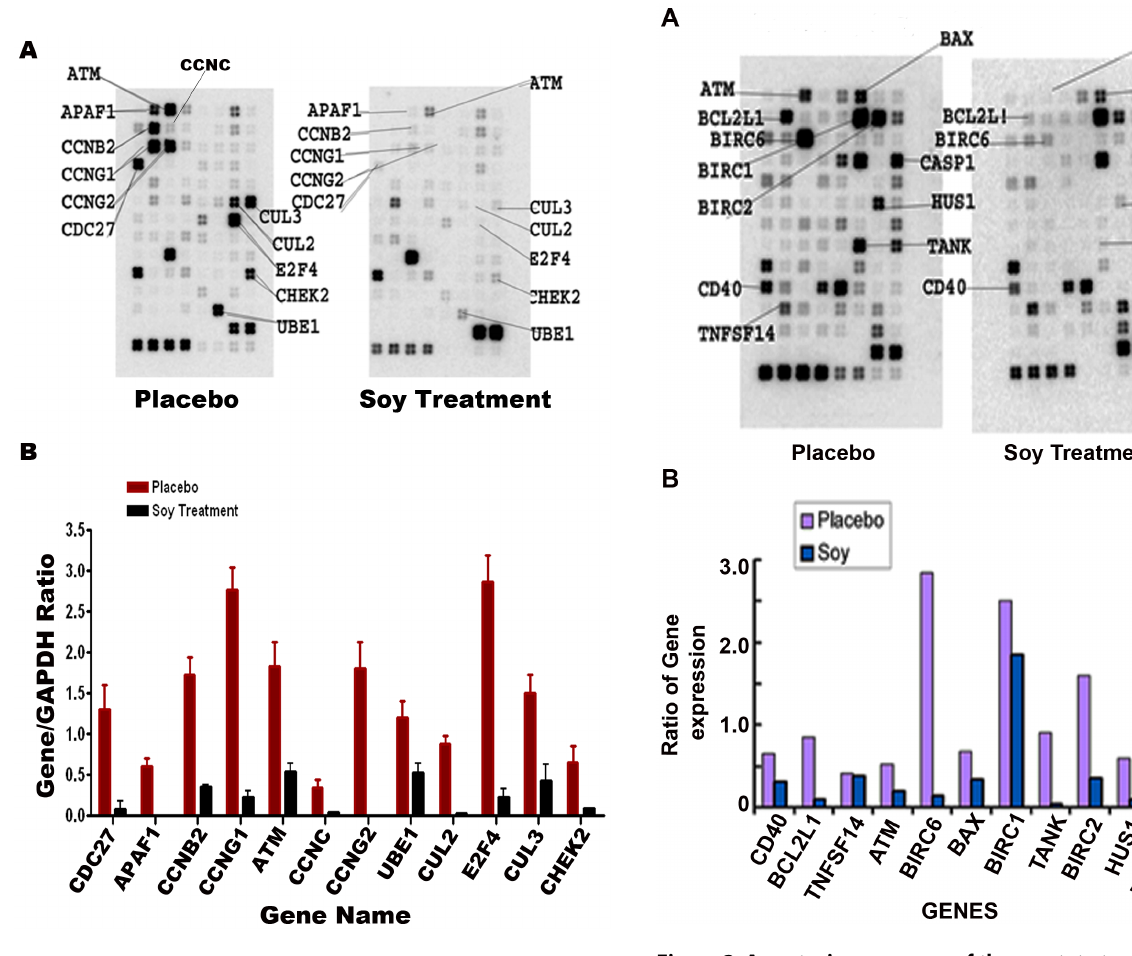
Figure 2. Cell cycle gene array of the prostate tumor specimen obtained from two patients with prostate cancer, one who consumed isoflavones and one who took the placebo. The figure shows the ratio of the gene to GAPDH.